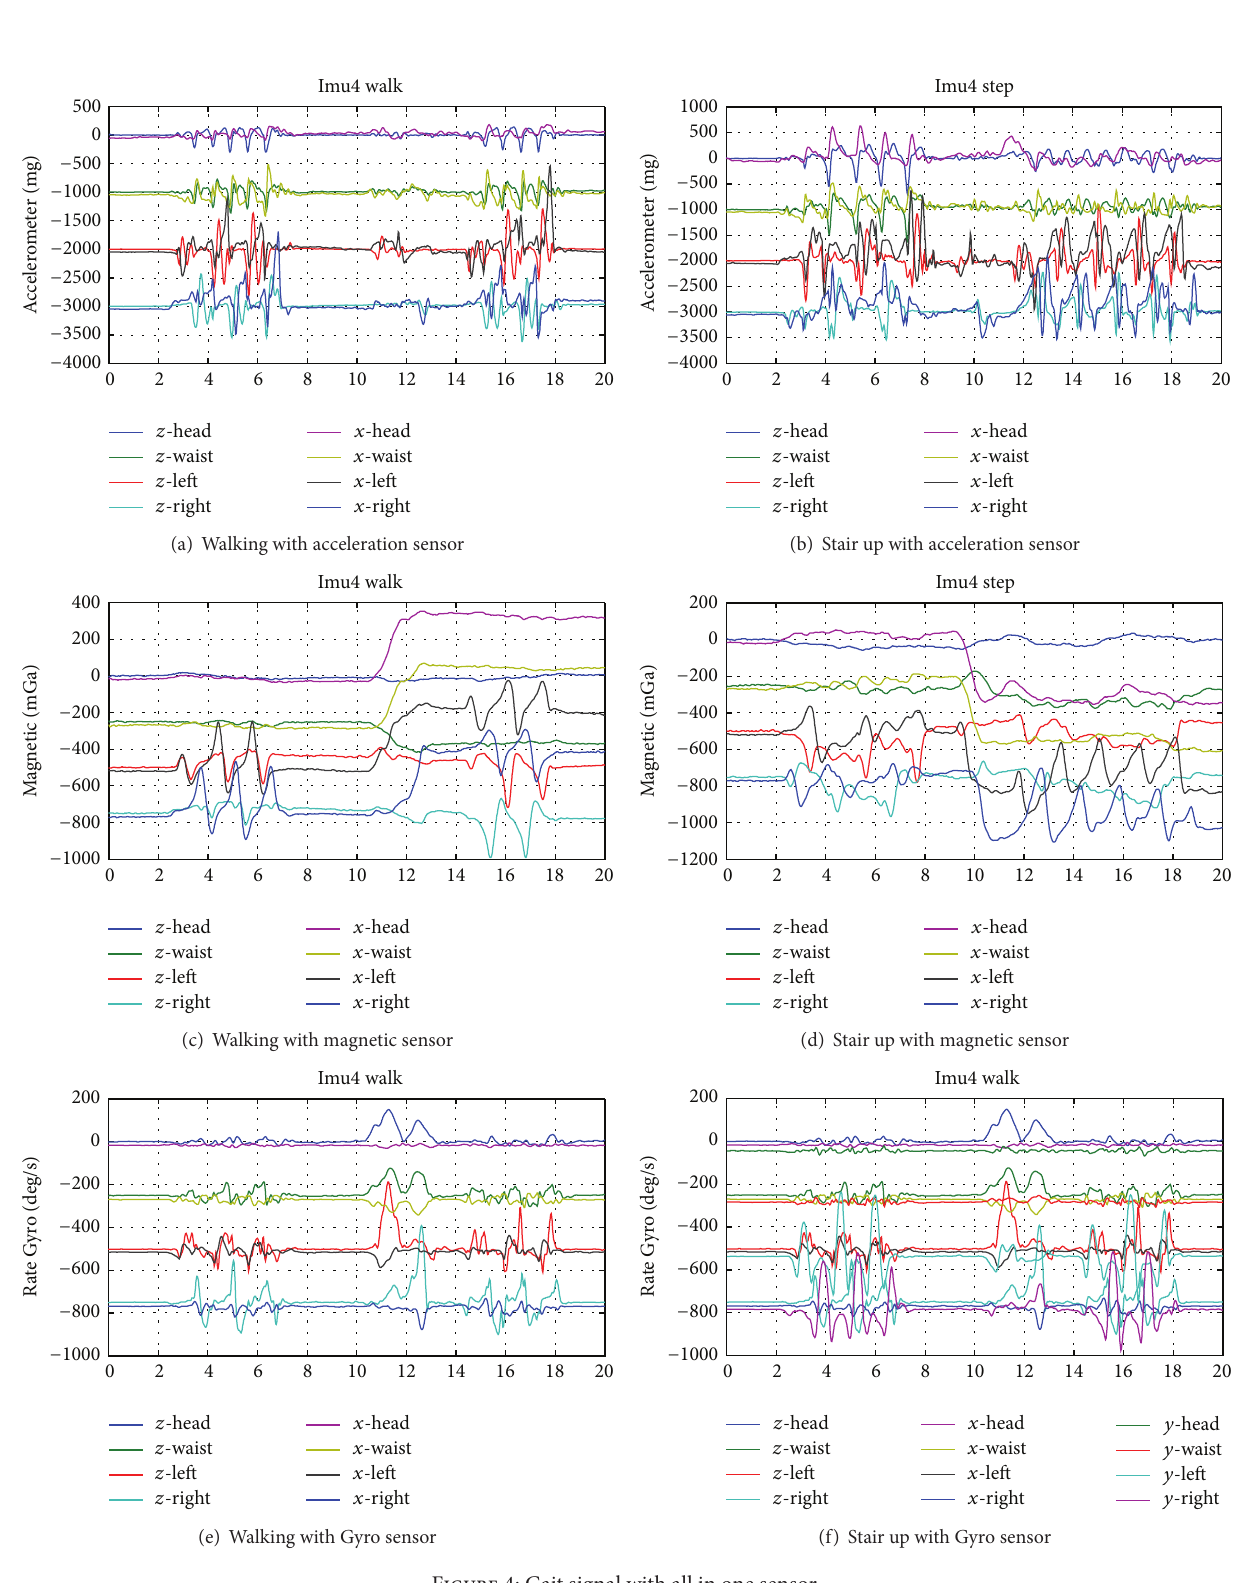
Figure 4: Gait signal with all in one